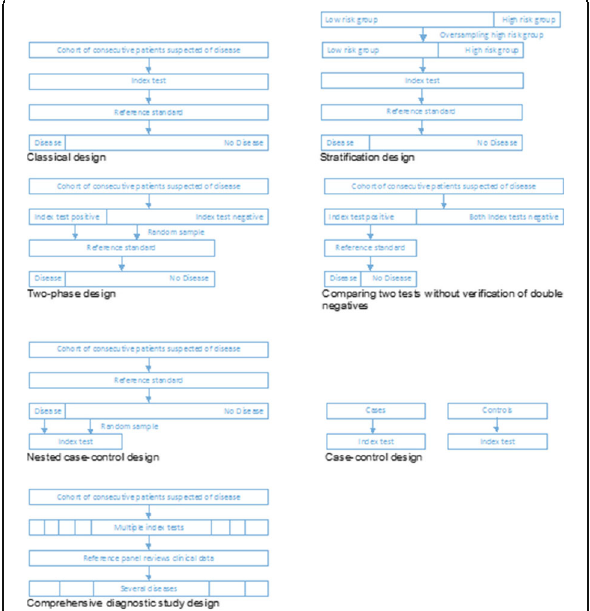
Fig. 1 (abstract O11). Study designs for diagnostic accuracy